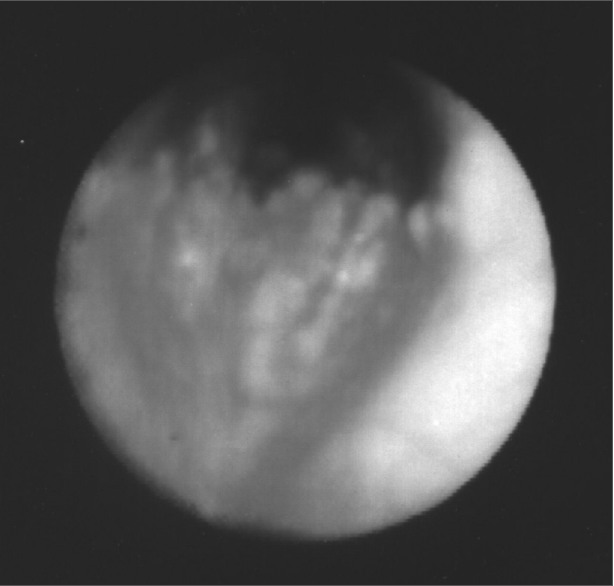
Figura 1. Fibrolaringotraqueobroncoscopia: região subglótica eviden- ciando as lesões nodulares múltiplas e difusas, com pregas vocais livres.